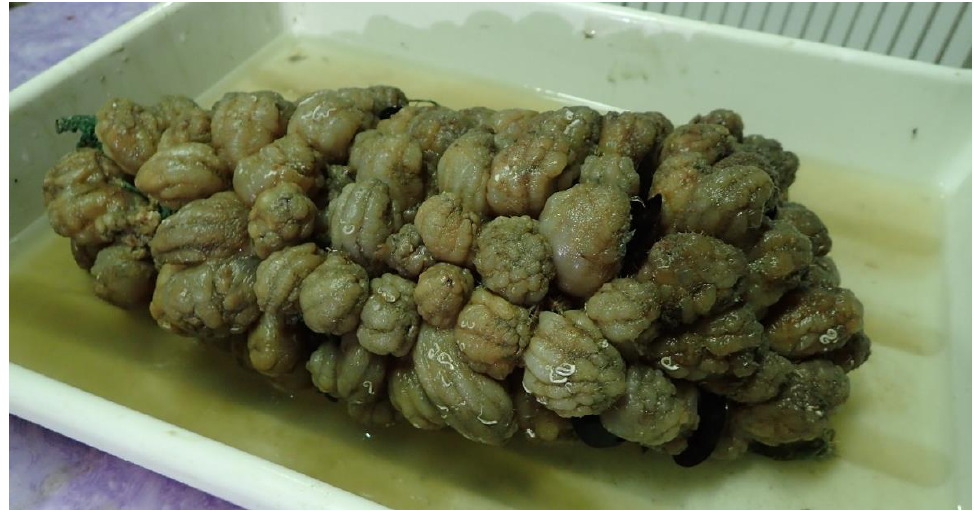
Figure 10. Collector bag from 2 m depth in Luka Cove completely covered with invasive ascidian Styela plicata (Lesueur, 1823).